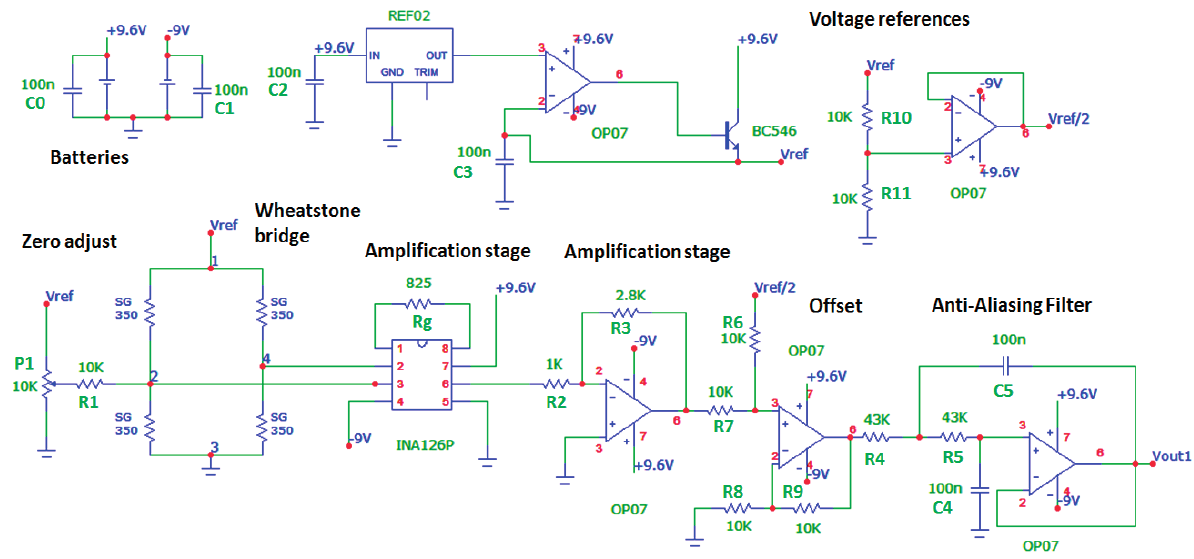
Figure 6. Channel 1’s conditioning